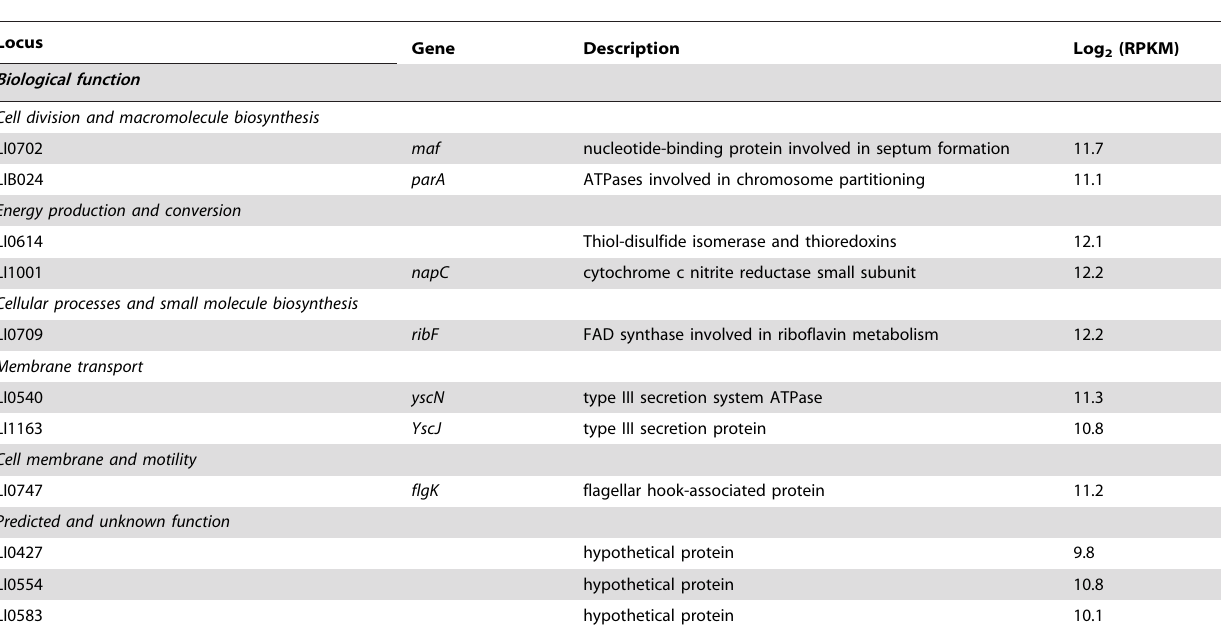
Table 2. Genes exclusively expressed by the non-pathogenic variant of the L. intracellularis isolate PHE/MN1-00.